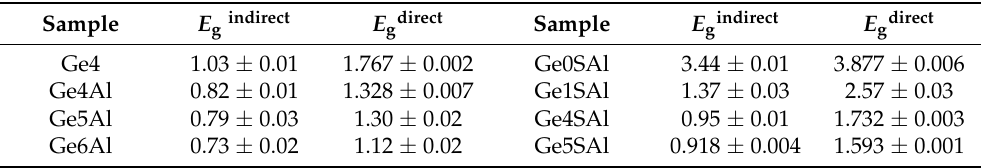
Figure 4. Optical gap determination. Tauc plot for the determination of indirect and direct bandgaps of the prepared materials. ( a – c ) Series with the Al shell, ( d – f ) series with the additional Si 3 N 4 shell. The dashed lines indicate the bandgap values in Ge QDs caused by confinement effects, calculated using formulas given in Refs. [32,33]. The symbols show schematic images of different QD structures that appear in the investigated films. Table 3. Bandgap values calculated from the absorption curves with the corresponding uncertainities. All values are given in eV.